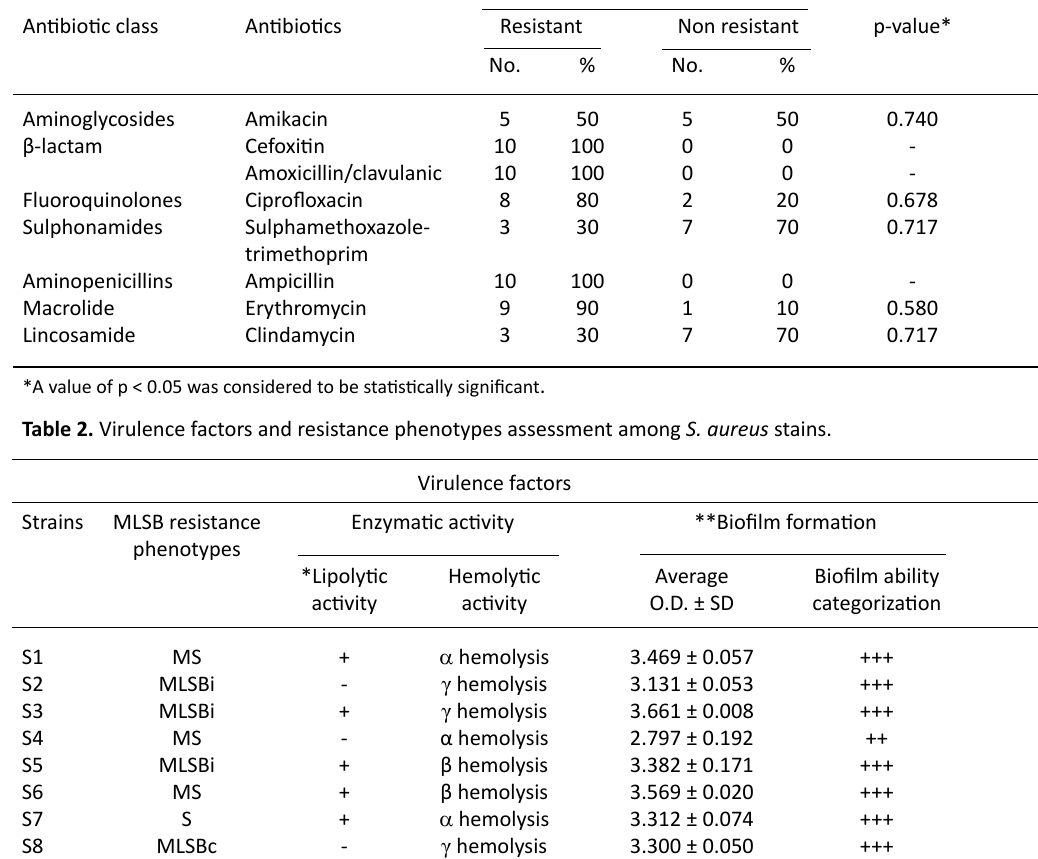
(Table 3). High resistance rates among tested MRSA strains were observed.